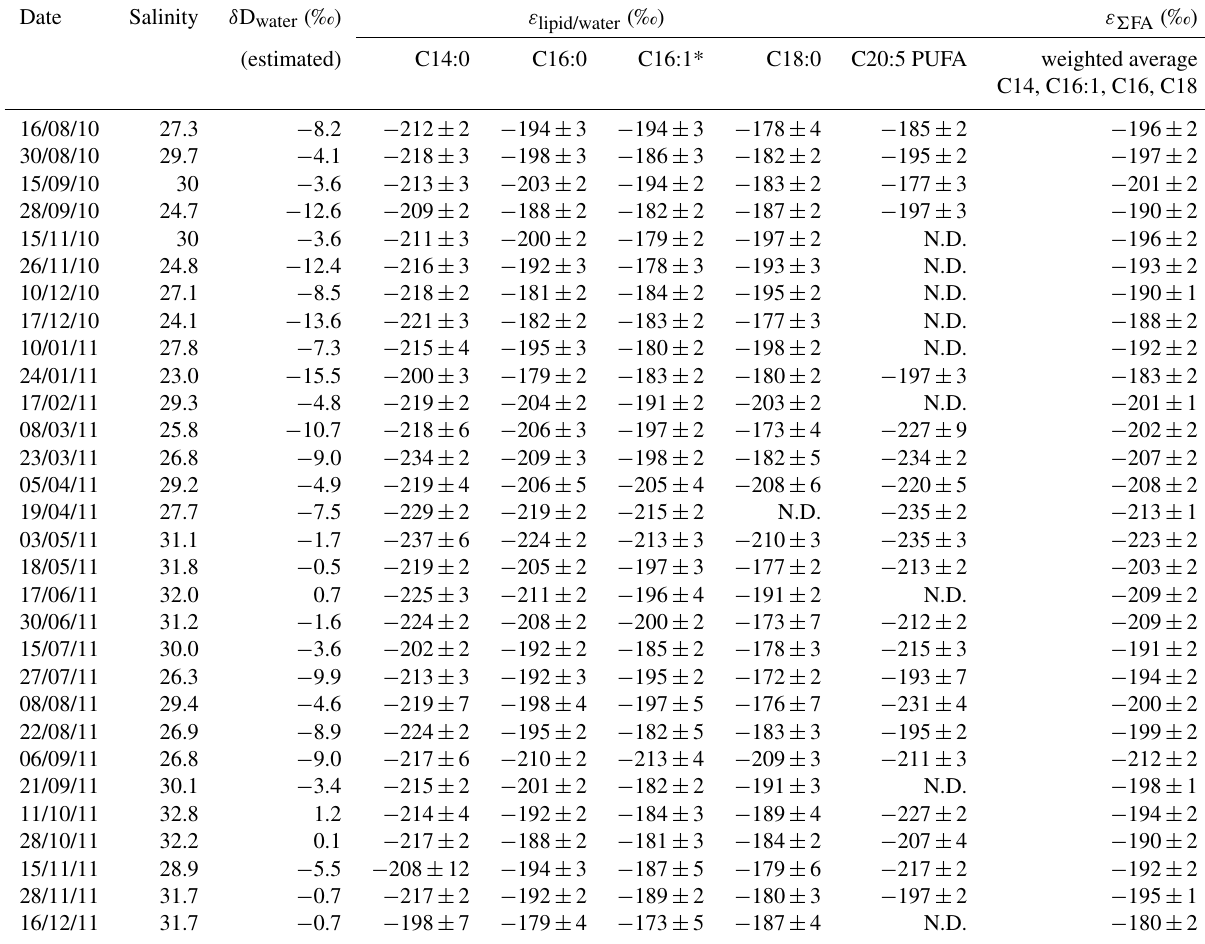
Table 1. D / H fractionation between fatty acids and North Sea water for fatty acids derived from suspended particulate matter in North Sea water samples. N.D. indicates not determined. Date format is